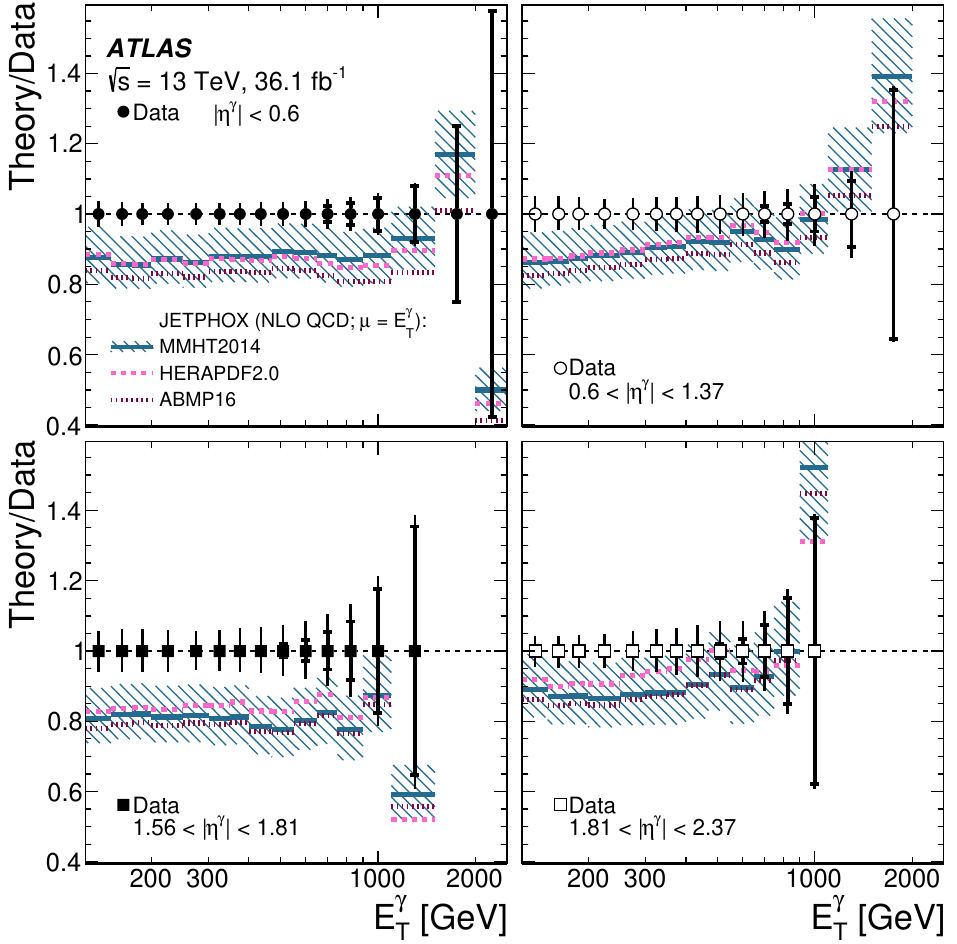
Figure 9 . The ratio of the NLO pQCD prediction of Jetphox with (cid:22) R = (cid:22) F = (cid:22) f = E (cid:13) MMHT2014 PDF set to the measured di(cid:11)erential cross section for isolated-photon production (solid lines) as a function of E (cid:13) in di(cid:11)erent regions of j (cid:17) (cid:13) j . The symbols for the data are centred at unity T and the inner (outer) error bars represent the relative data statistical uncertainties (statistical and systematic uncertainties added in quadrature). The hatched bands represent the full theoretical uncertainty associated to the prediction based on the MMHT2014 PDF set, including the variations of the scales. For comparison, the predictions using the HERAPDF2.0 (dashed lines) and ABMP16 (dotted lines) PDF sets are also